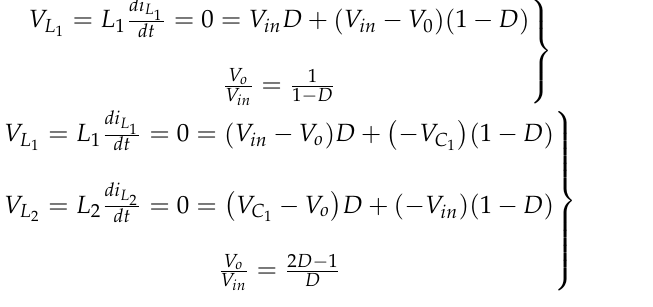
Figure 8. Circuit diagram of one of the converters considered in this study (G2).